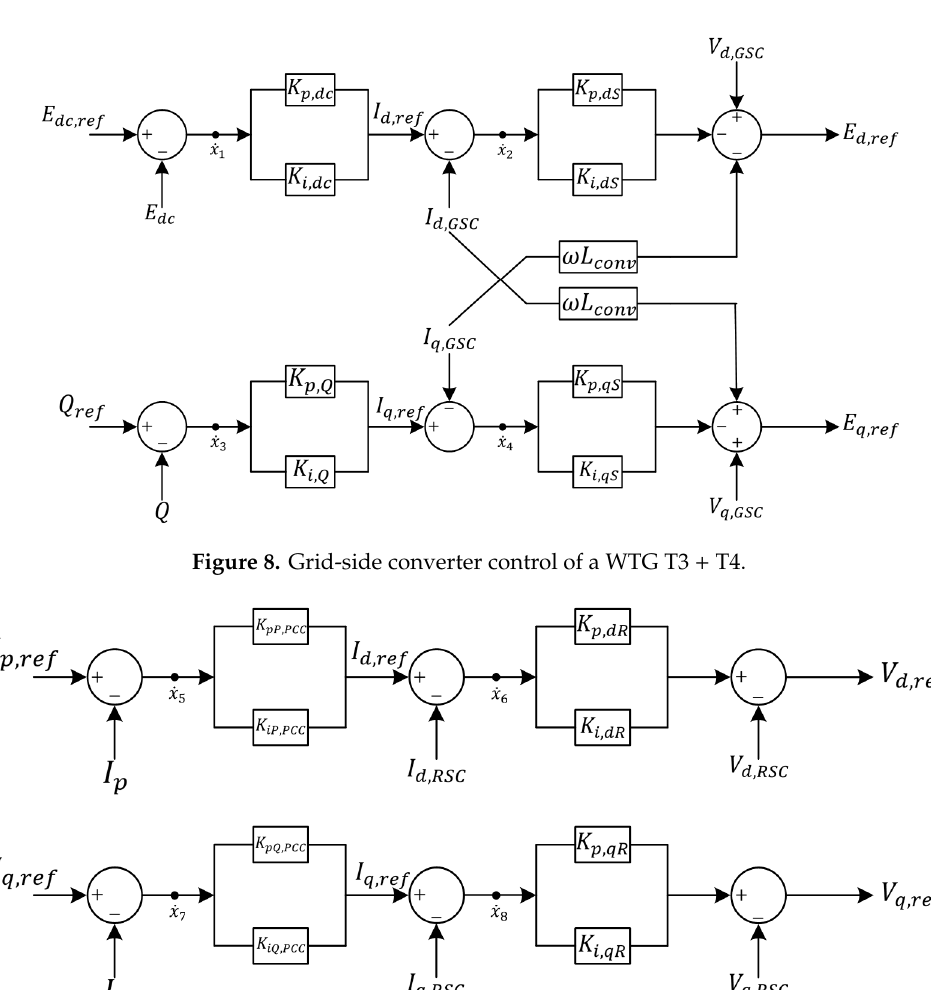
Table 1. Influence of operating conditions and converter parameters on DFIG-SSR and SSCI.